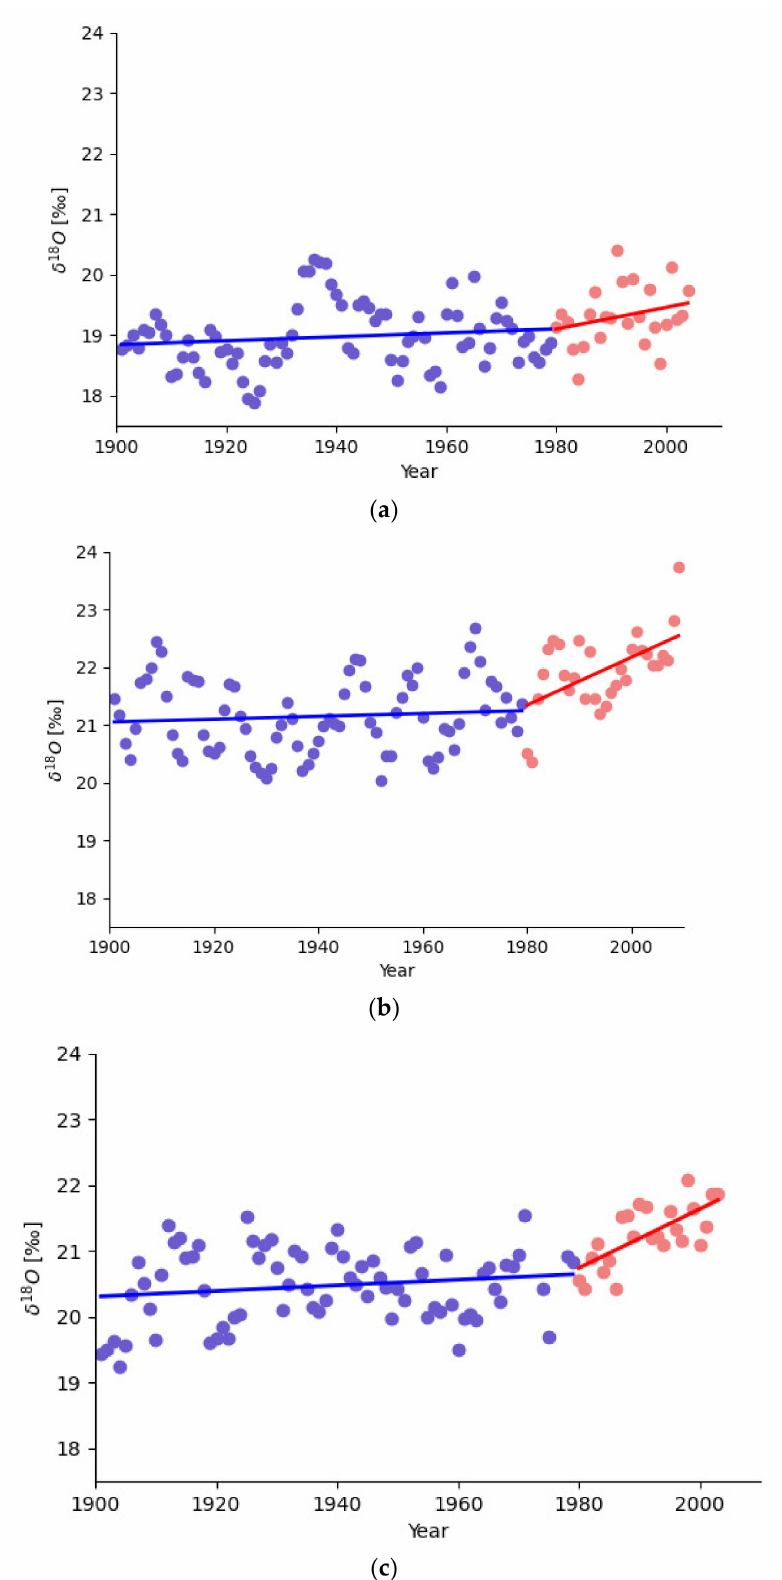
Figure 7. Annually resolved δ 18 O in tree-ring cellulose ( δ 18 O cell ) chronologies and their trends for northeastern Yakutia (YAK) ( a ), eastern Taimyr (TAY) ( b ) and the Mackenzie Delta (CAN) ( c ). Trends are marked in blue for the period from 1900 to 1979 and in red for the period from 1980 to 2004 for YAK, and from 1980 to 2009 for TAY and CAN,